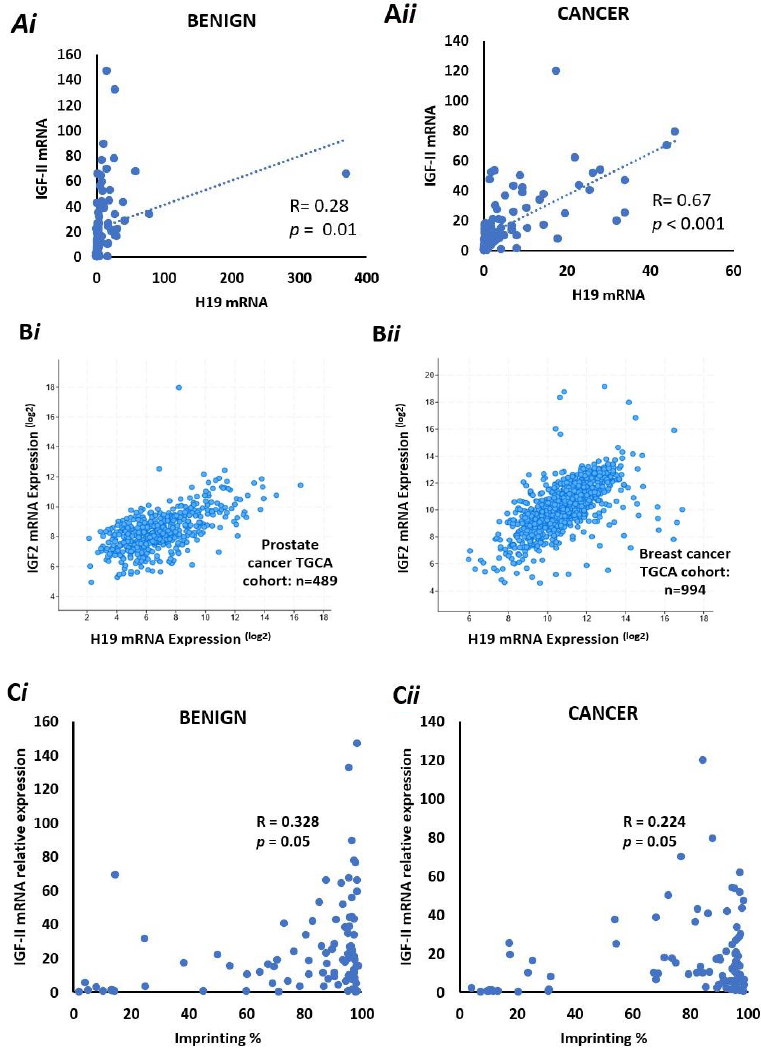
Figure 4. Co-expression of IGF-II & H19 mRNA and IGF-II & % imprinting in benign and prostate cancer tissue sections. ( A ) Co-expression of H19 & IGF-II mRNA in benign ( i) and cancer ( ii ) derived from FFPE prostate tissue from the PrEvENT cohort. Pearson’s correlation coefficient analy- sis found a significant ( p = 0.01) weak positive (R = 0.28) correlation between H19 and IGF-II